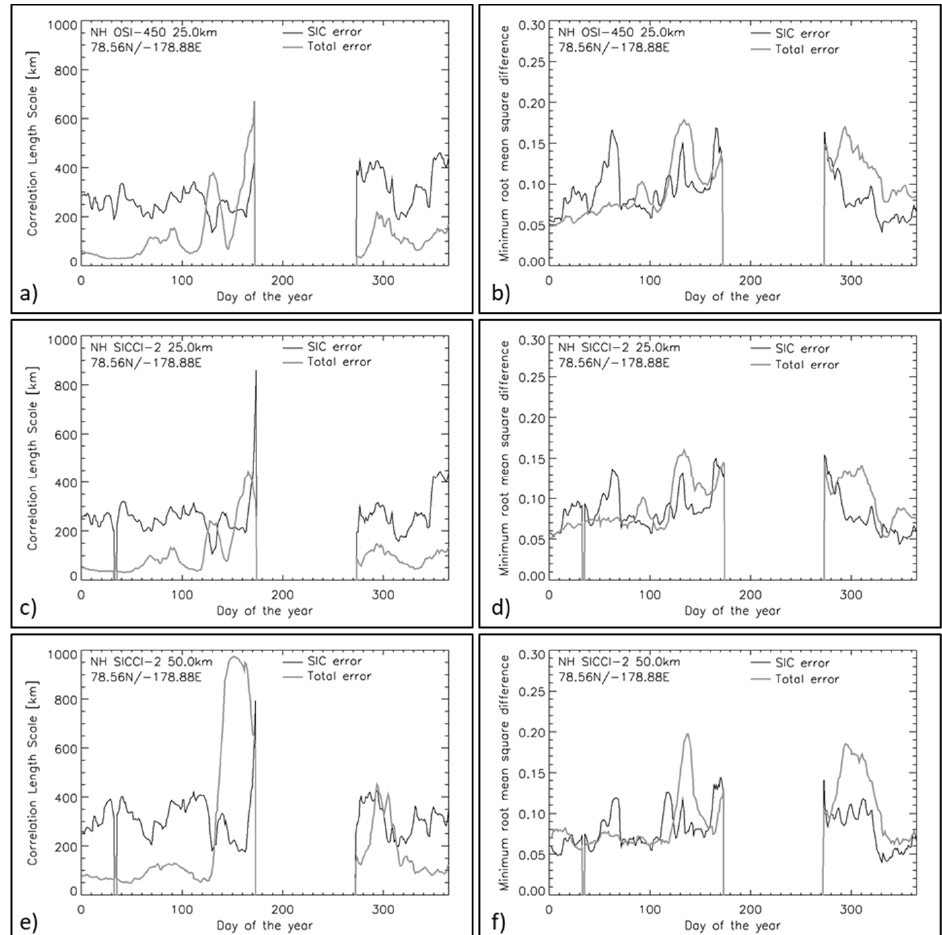
Figure 10. Time series of the average correlation length scale (left column) and RMSD (right column) for a 7 × 7 grid cells area at 50 km (350 km × 350 km) and a 13 × 13 grid cells area at 25 km (325 km × 325 km) north of Wrangell Island for OSI-450 ( a , b ), SICCI-25km ( c , d ) and SICCI-50km ( e , f ). Each panel shows time series for the SIC error correlation length scale and the total error correlation length scale. Zero values denote data gaps due to either missing data files (two days between day of the year 30 and 40 in panels ( c – f ) or due to SIC values dropping below 90% (between day of the year 170 and 275).